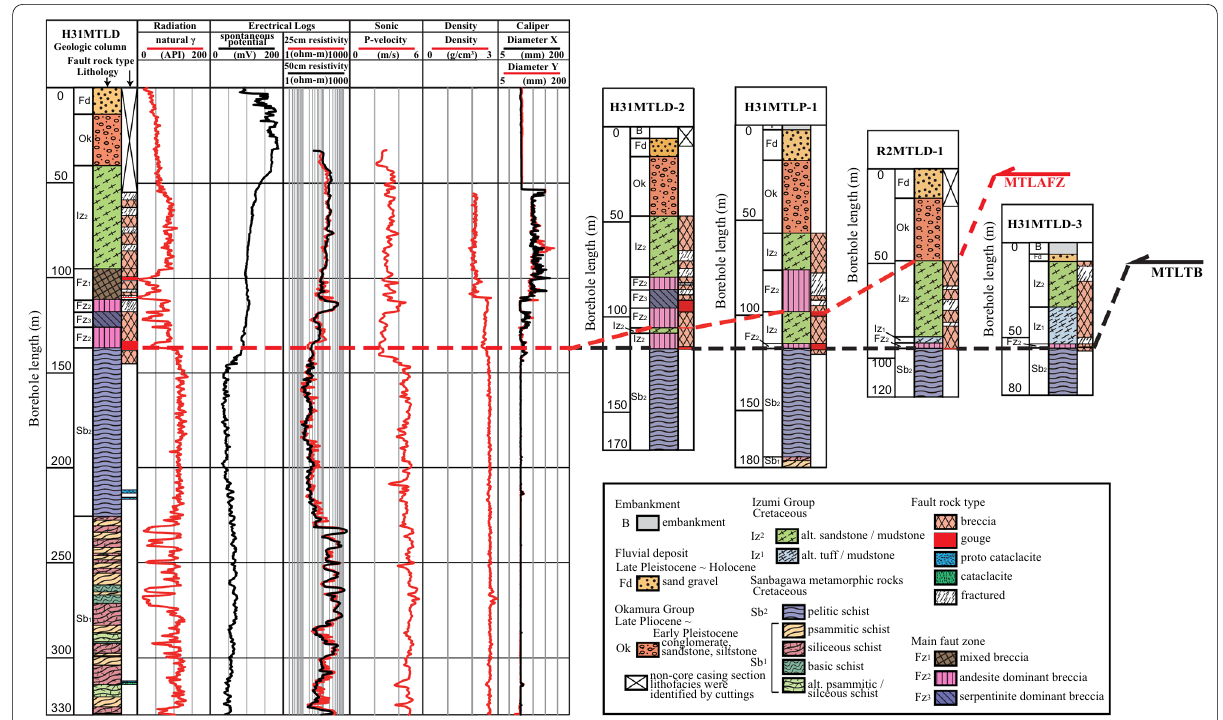
Fig. 3 Geological columns and composite well logging profiles. Diagrams showing the geological columns and composite well logging profiles of H31MTLD-1, and the geological columns of H31MTLD-2, H31MTLP-1, R2MTLD-1, and H31MTLD-3 at the Yuyaguchi